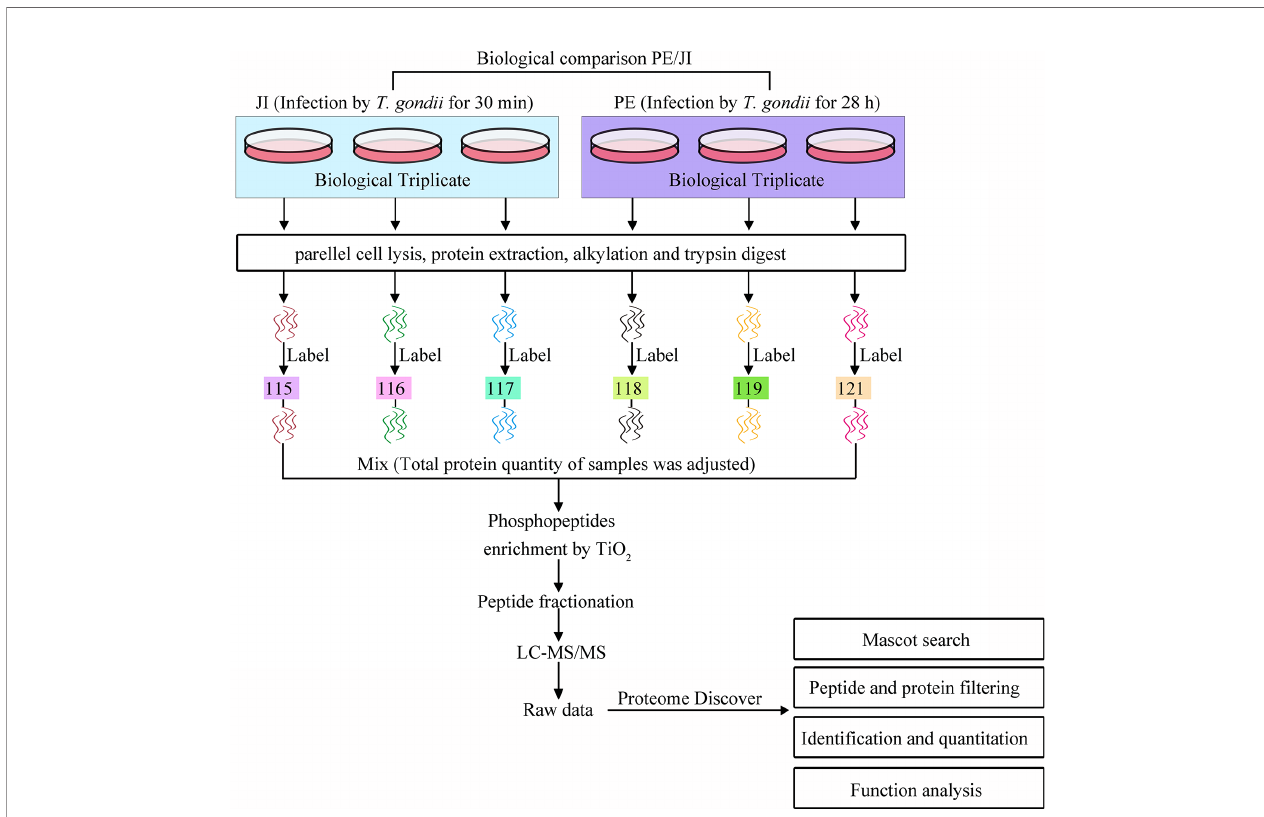
FIGURE 1 | Processes of the iTRAQ-based phosphoproteomic analysis of T. gondii tachyzoites at the stages of “ just invading ” and “ prior to egress ” . Two biological triplicates of cells infected with T. gondii RH tachyzoites for 30 min or 28 h, respectively, at a MOI of 3 were collected for the phosphoproteomic analysis of T. gondii tachyzoites. All the six samples were digested with trypsin and labeled with iTRAQ. The labeled phosphopeptides were enriched with TiO2, and subjected to LC-MS/ MS analysis. The generated phosphoproteomic data were then qualitatively, quantitatively, and functionally